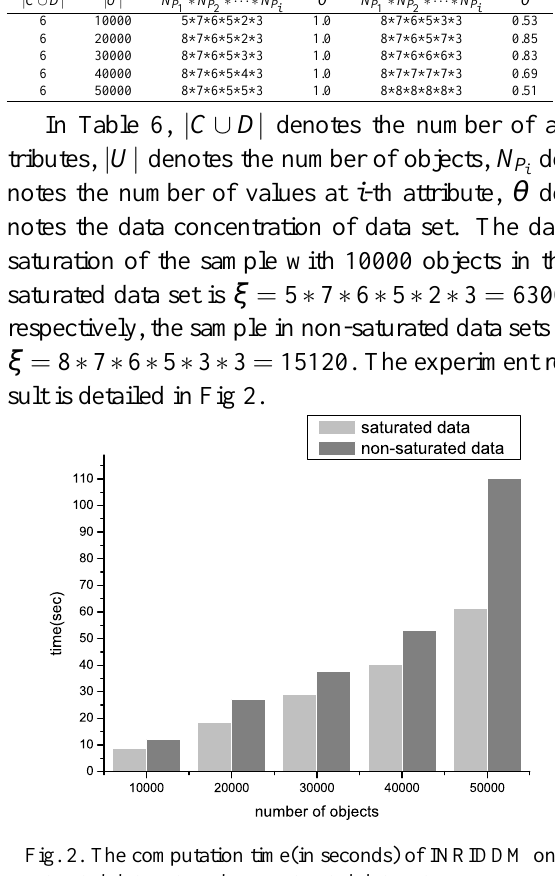
Fig. 3. The computation time(in seconds) of INRIDDM on data sets with different